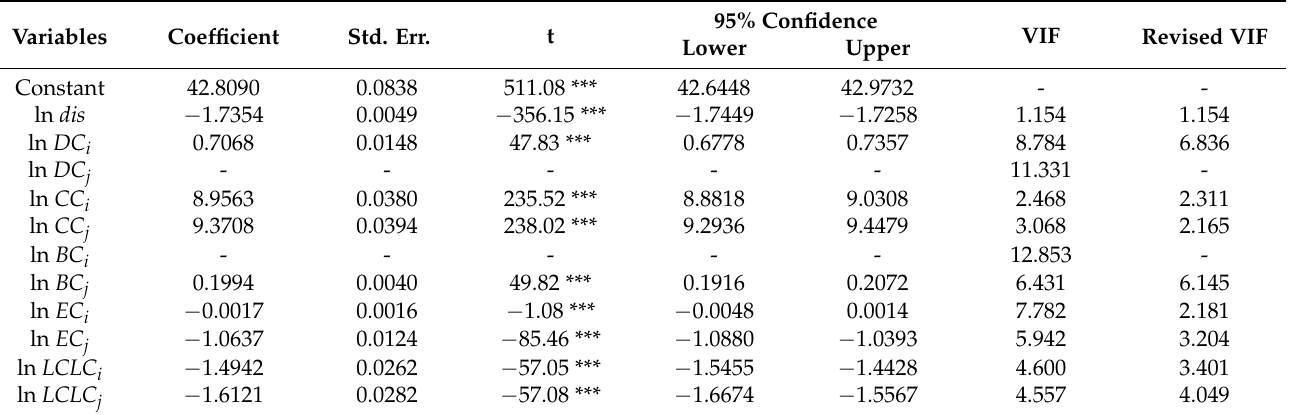
Table 5. The estimation of variables’